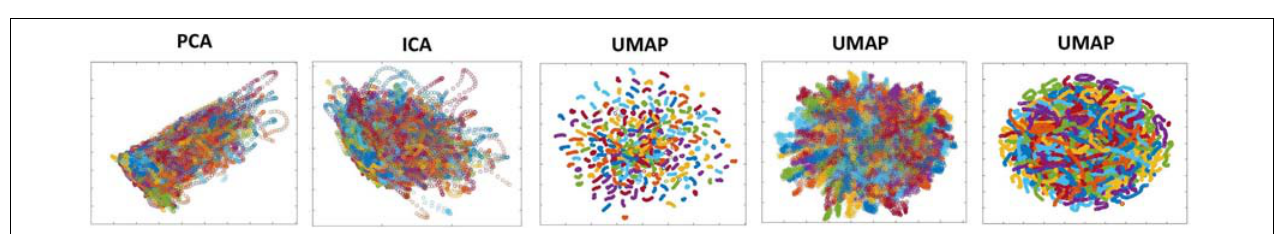
FIGURE 3 | Applying different data reduction methods to the 1,081-dimensional dFNC observations yields various planar presentations. PCA (column 1) and spatial Independent Component Analysis (ICA) (column 2) are “cloudy” and do not produce continuous, well-defined, subject-level trajectories; UMAP with n_neighbors = 200 and min_dist = 0.1 (column 3) has a large periphery of isolated geometrically compressed trajectories; UMAP with n_neighbors = 200 and min_dist = 0.8 (column 4) results in a crowded but diffuse embedding that blurs within-subject temporal trajectory continuity. UMAP with the parameters used in